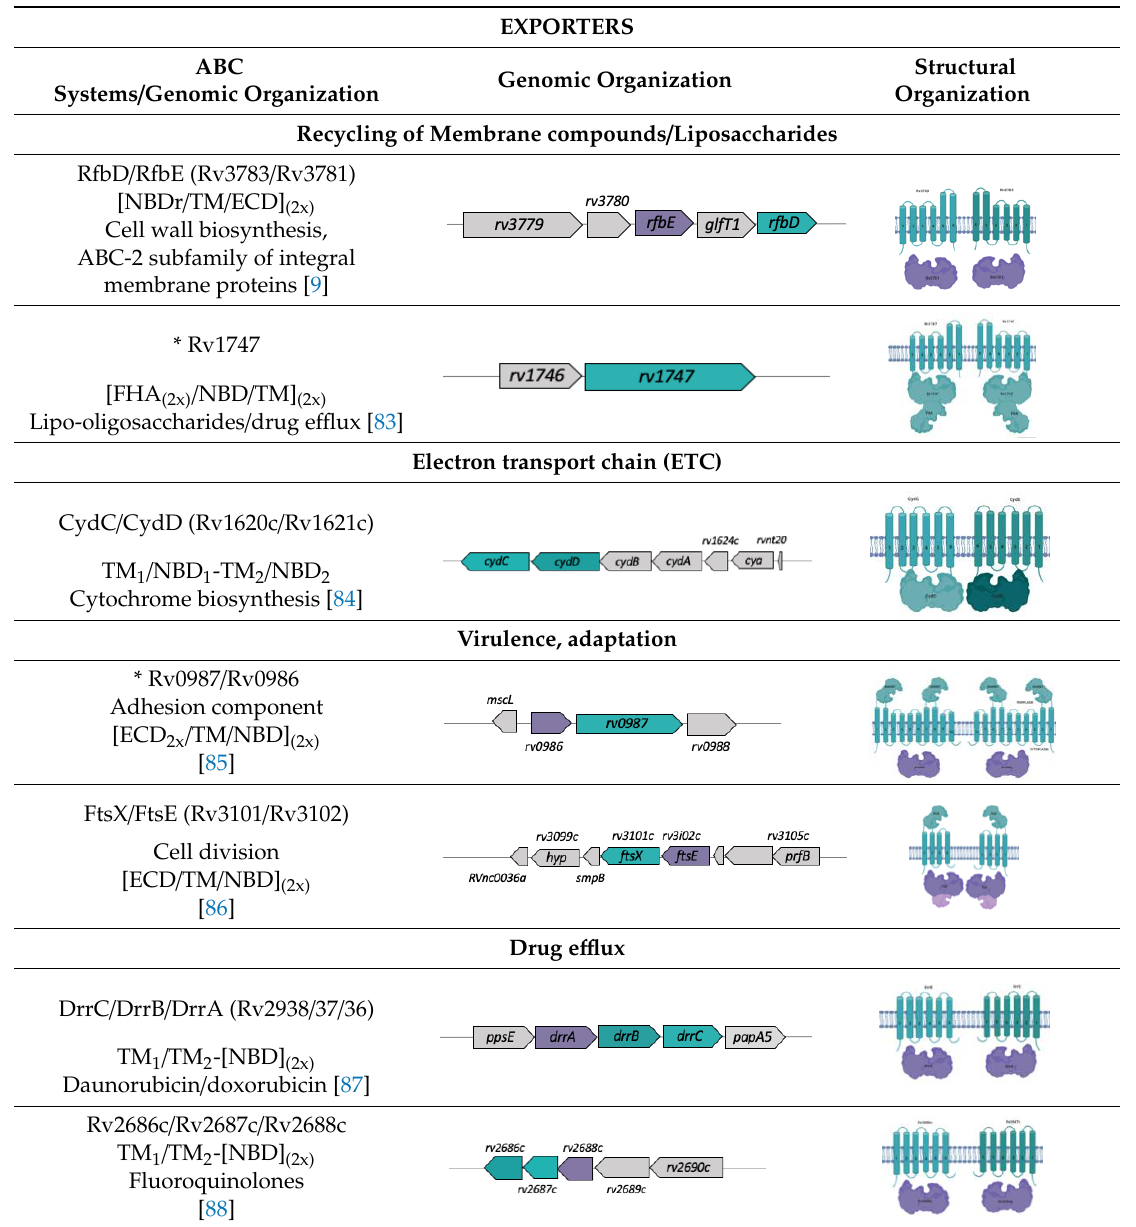
Table 3. Genomic context and structural organization of ATP- binding cassette (ABC) export systems in Mycobacterium tuberculosis . The ABC exporters are divided into four groups according to their function. Genes that belong to the genomic context are shown as arrows. The predicted number and structural organization of TM helices and structural organization according TOPCONS are shown in the last column, where transmembrane domains (TMDs) are colored in clear and dark green, nucleotide-binding domains (NBDs) in purple, and regulatory domains (when present) in pale purple. FHA is the fork-head associated domain and ECD is the extracellular domain.